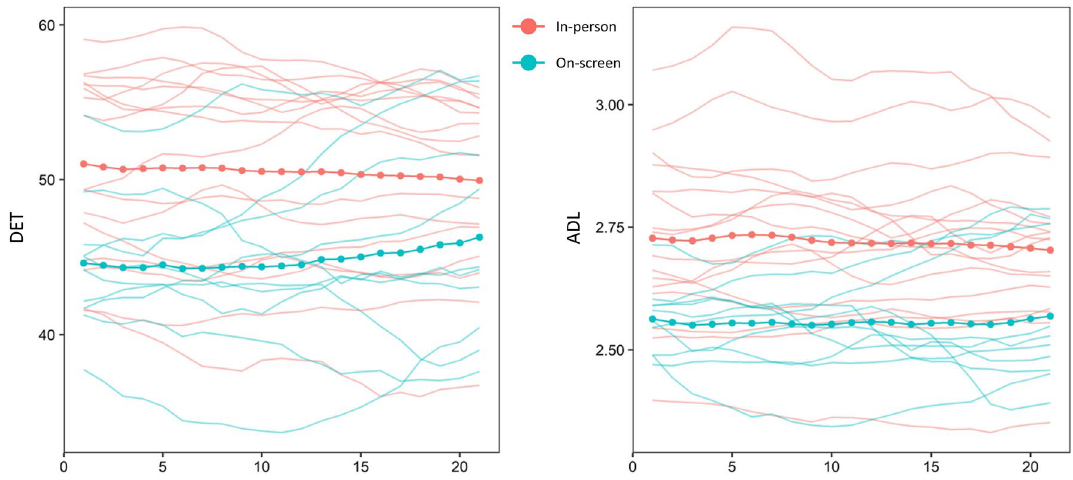
Figure 4. Windowed MdRQA. Each time series of each game was divided into 21 overlapping windows (horizontal axis) extending 80% of the length of the original time series.